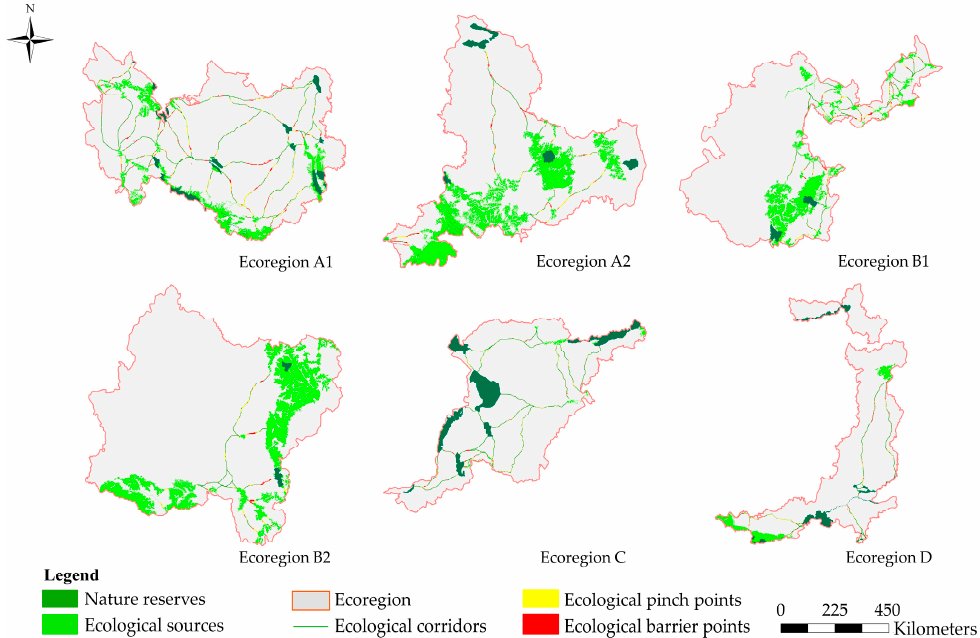
Figure 10. Spatial distribution of ecological security patterns (ESPs) in each ecoregion. Among all the ecoregions, we identified 2801 ecological pinch points with a total area of 851.07 km 2 , and 3657 ecological barrier points with a total area of 800.70 km 2 . Ecoregion A1 had 961 pinch points with a total area of 330.84 km 2 and 1448 barrier points with a total area of 307.4 km 2 ; A2 had 274 pinch points with a total area of 106.79 km 2 and 685 barrier points with a total area of 108.9 km 2 ; B1 had 408 pinch points with a total area of 93.3 km 2 and 429 barrier points with a total area of 90.24 km 2 ; B2 had 198 pinch points with a total area of 67.56 km 2 and 131 barrier points with a total area of 62.75 km 2 ; C had 473 pinch points with a total area of 121.09 km 2 and 444 barrier points with a total area of 100.2 km 2 ; and D had 487 pinch points with a total area of 131.49 km 2 and 520 barrier points with a total area of 131.21 km 2 . As discussed, ecoregion A1 had the largest number and longest length of corridors, reflective of complex ecological resistance and high ecological vulnerability. Therefore, A1 also has the largest numbers and areas of pinch points and barrier points. Ecoregion B2 had the small numbers and shortest lengths of corridors, and so also had the smallest numbers and areas of pinch points and barrier points. In ecoregion A1, grassland accounted for the largest proportion (65.10%) of pinch points (Figure 11a); artificial surface land (2.02%) and unutilized land (2.37%) accounted for the smallest proportions. In A2, grassland accounted for the largest proportion (43.45%), while water bodies (0.48%), artificial surface land (0.47%), and unutilized land (0.40%) accounted for the smallest proportions. In B1, cultivated land accounted for the largest proportion (41.19%), and unutilized land accounted for the smallest proportion (0.01%). In B2, grassland land accounted for the largest proportion (56.70%) and unutilized land accounted for the smallest proportion (0.06%). In C, grassland accounted for the largest proportion (59.00%) and artificial surface land accounted for the smallest proportion (0.54%). In D, cultivated land accounted for the largest proportion (34.29%) and unutilized land accounted for the smallest proportion